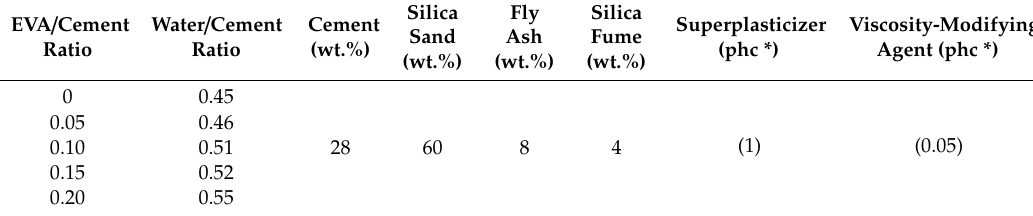
Table 9. Mixture proportions of EVA-modified cementitious mixtures.